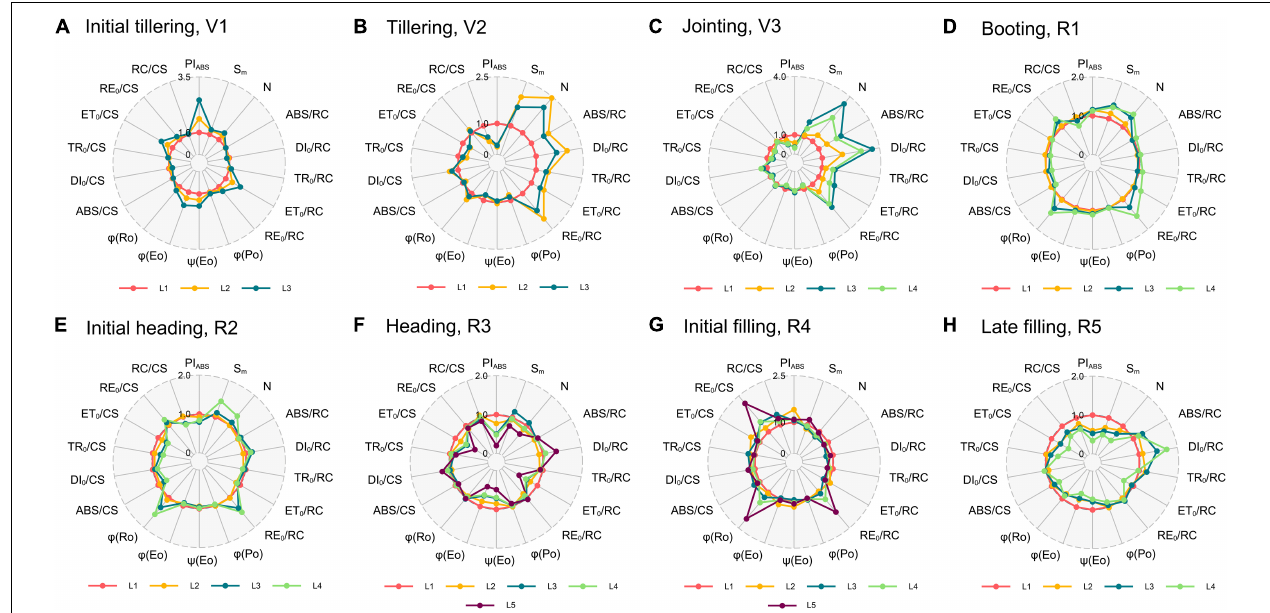
FIGURE 4 | Radar plots of the N1 treatment with a series of important parameters derived from experimental fast OJIP transients during different growth stages [ (A) , initial tillering; (B) , tillering; (C) , jointing; (D) , booting; (E) , initial heading; (F) , heading; (G) , initial filling; (H) , late filling]. These parameters for each leaf are the average of all samples with the N1 treatment. Taking each leaf at the L1 position as the control (each parameter equals 1, denoted by a red circle) and parameters of another leaf of the stage are expressed by fraction relative to the corresponding value of L1 layer leaf. Individual data points are the mean value of four biological replicates. L1–L5 represent the leaf position from bottom to top of the plant.